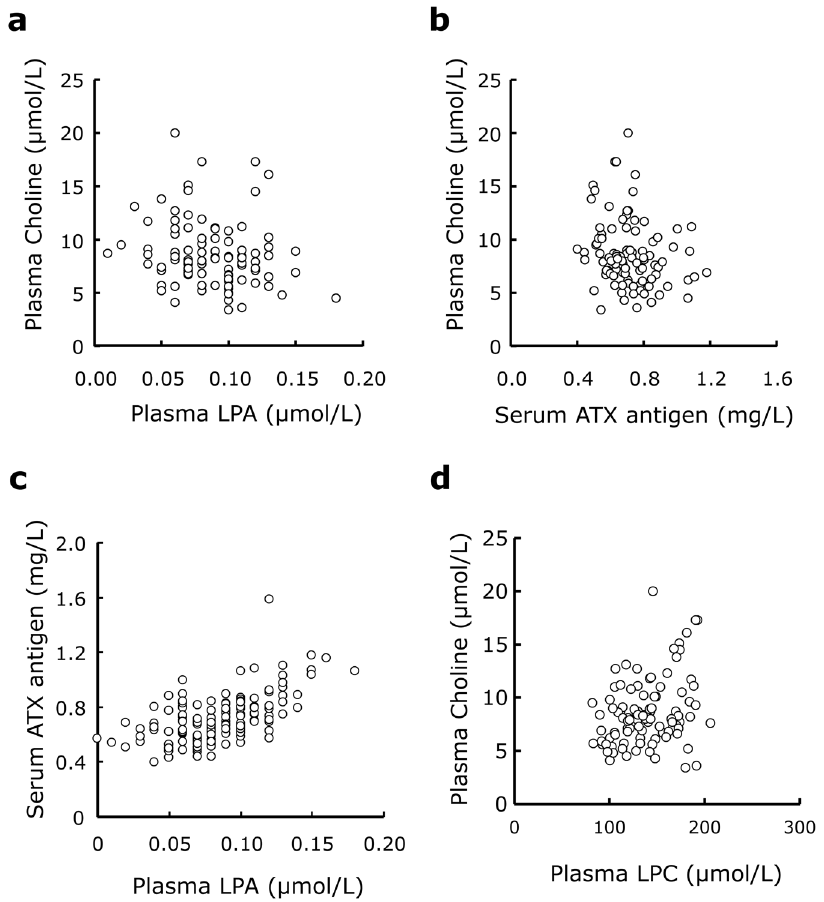
Figure 4. Correlations between plasma choline and ATX-related metabolites. Plasma choline, LPA, and LPC and serum ATX antigen levels were measured in healthy human subjects (n = 98). The correlations between plasma choline and plasma LPA ( a ), serum ATX antigen ( b ), and plasma LPC ( d ) and between serum ATX antigen and plasma LPA ( c ) were then